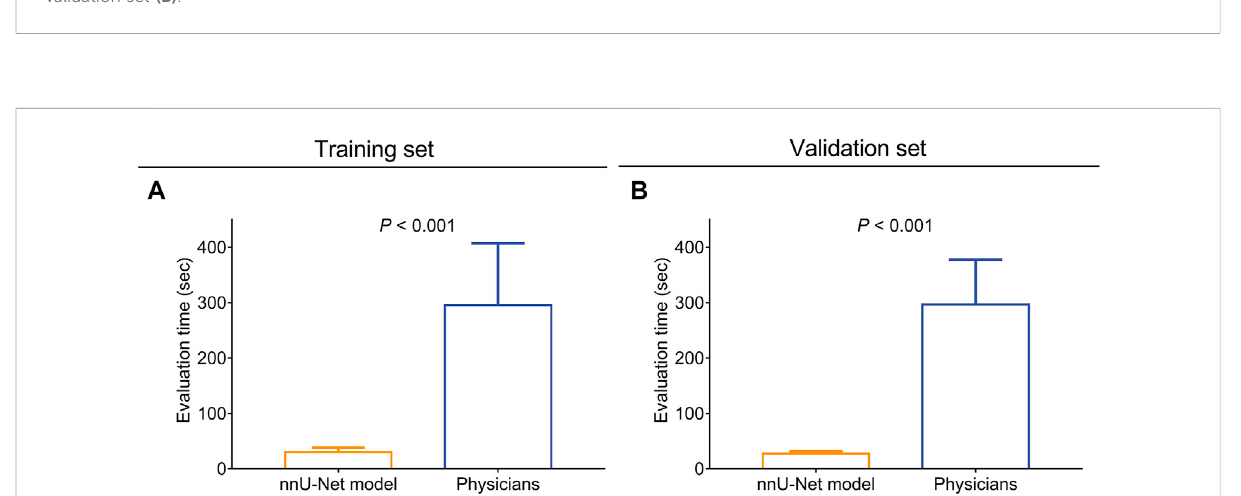
FIGURE 4 ThennU-NetmodeltooklesstimeforCASandatheroscleroticplaqueevaluationcomparedwithphysicians.Comparisonoftheevaluationtime between the nnU-Net and physicians in the training set (A) and the validation set (B)